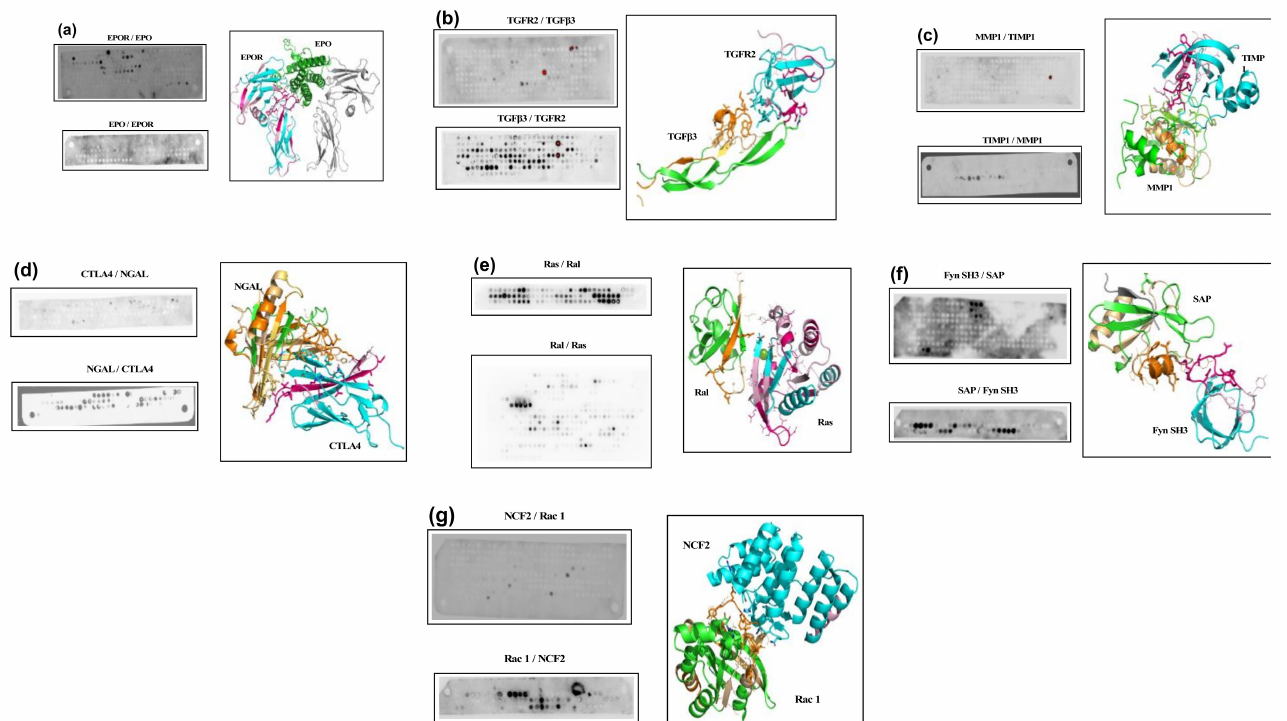
Figure 1. PEPscan applied to protein-protein interactions. Panels A to G correspond to the EPO/EPOR, TGFR2/TGF β 3, MMP1/TIMP1, CTLA4/NGAL, Ras/Ral, Fyn SH3/SAP, and NCF2/Rac 1 complexes, respectively. For each, two PEPscan membranes are presented (X/Y and Y/X), X/Y meaning X corresponds to the membrane and Y to the protein in use for the hybridization. The 3D structure of the complex is depicted, with candidate fragments and MOFs in wheat/orange for partner 1 and purple/pink for partner 2. Side chains of the candidate fragments and the MOFs are depicted as lines and sticks,